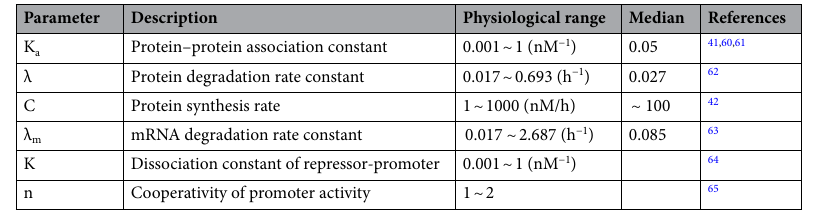
Table 1. Physiological ranges of model